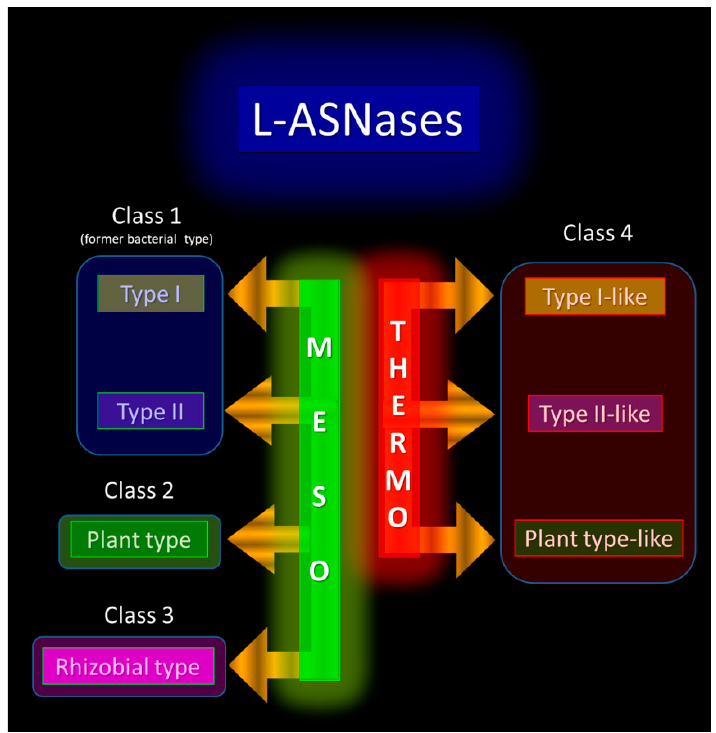
Figure 2. Proposed classification of L-ASNases, including thermo-ASNases as a novel Class 4. 3. L-ASNases as Key Metabolic Enzymes for Thermophilic and Hyperthermophilic Mi-